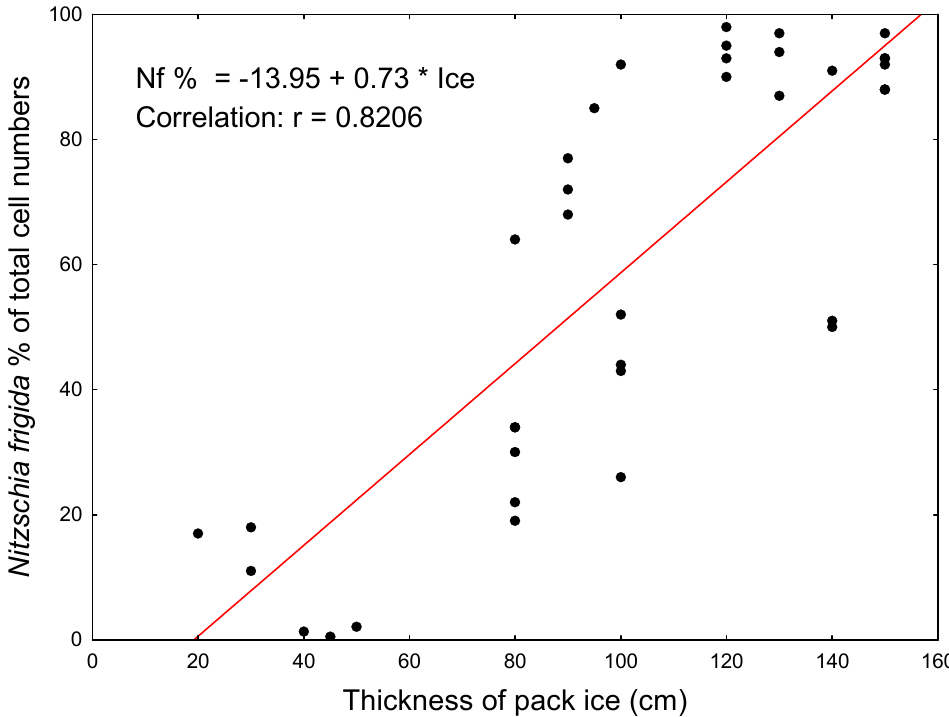
Figure 6. Regressions of the pack ice thickness and the percentage dominance of the ice diatom Nitzschia frigida in the Barents Sea The two common species, N. promare and F. arcticus , both showed a significant nega- tive relationship for dominance and for cell numbers with N. frigida % cell dominance. Both N. promare and F. arcticus had a significant positive relationship with surface water nitrate, N. promare also with silicate. There was a significantly negative relationship be- tween snow depth and dominance of F. arcticus . The co-occurrence of these two species was significantly positively related.